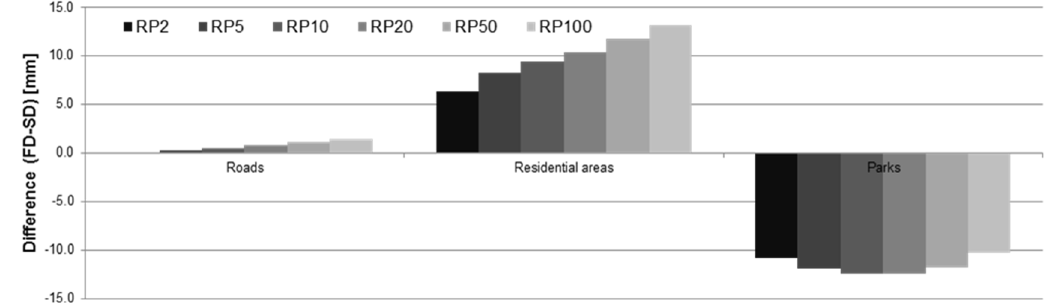
Figure 17. Differences on flooding volumes of each land use group for design storms events, Zona Central case study.